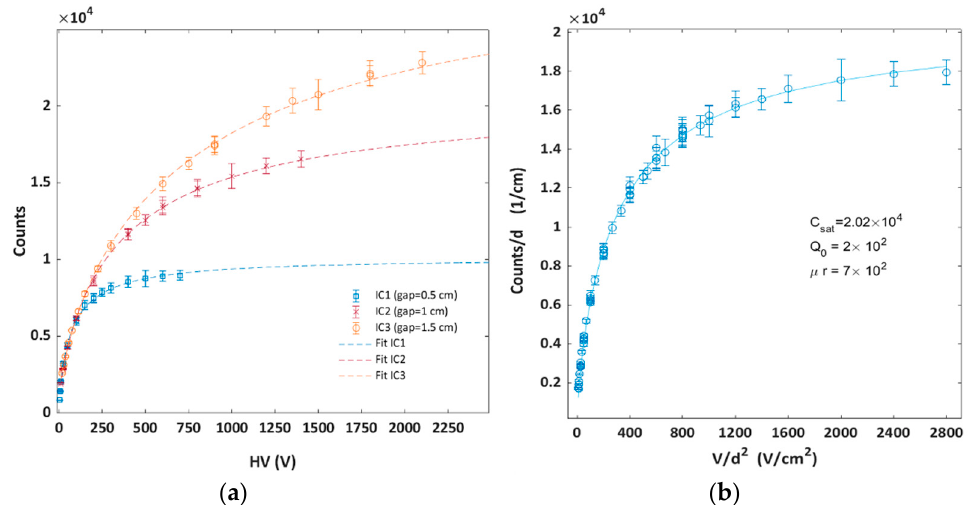
Figure 10. ( a ) Average counts per pulse normalized to the Faraday cup measured charge as a function of the bias voltage for 500 µs pulse width and corresponding fits with the Boag formula for pulsed beams; ( b ) total counts normalized to the detector gap and fit.